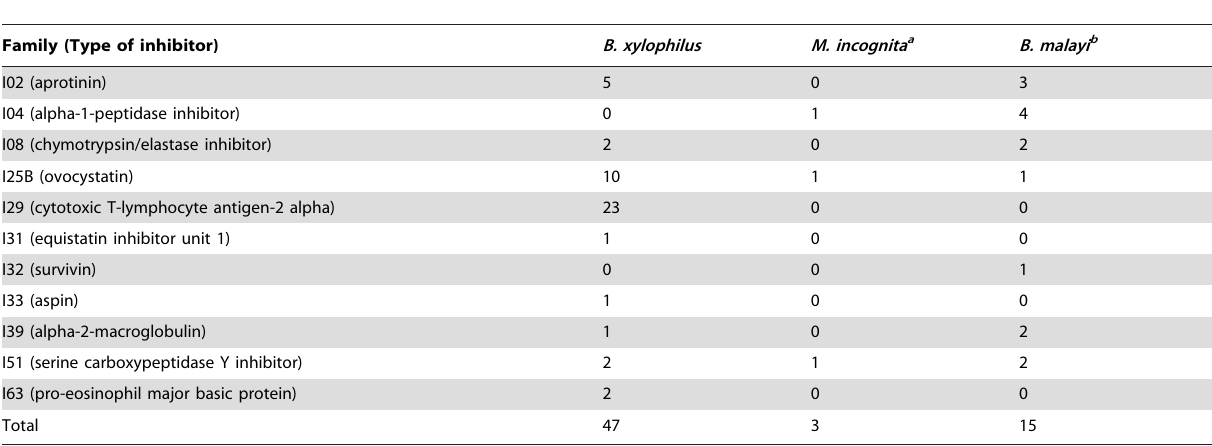
Table 5. Summary of secreted peptidase inhibitors in Bursaphelenchus xylophilus and other nematodes.